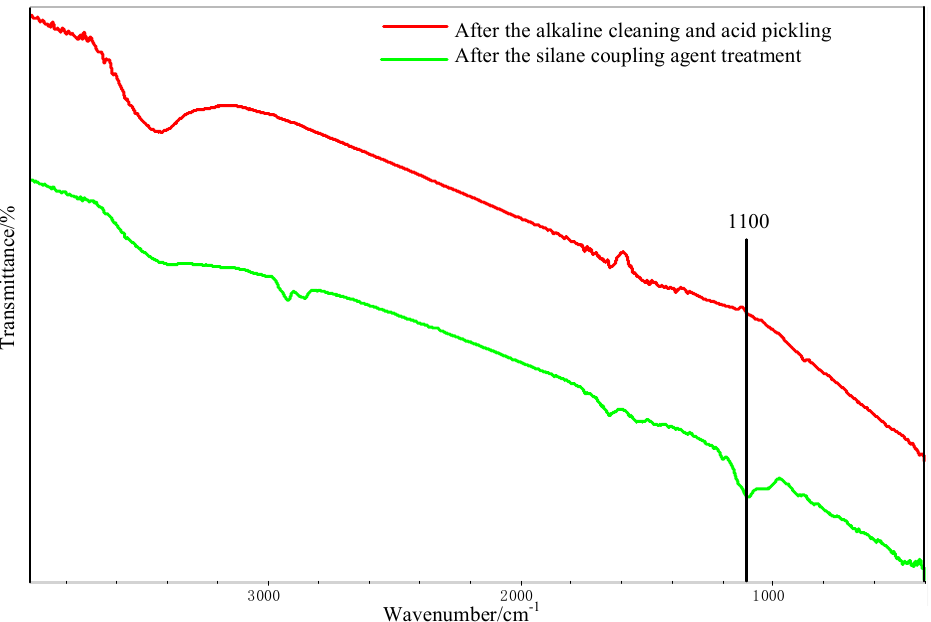
Figure 11. Fourier transform infrared spectrometer (FTIR) spectra of the Al alloy surface.